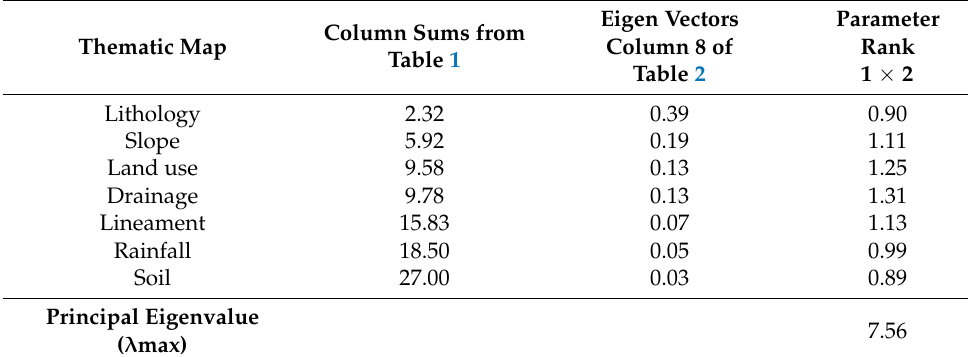
Table 7. Calculation of the principal eigenvalue to rank factors. Thematic Map